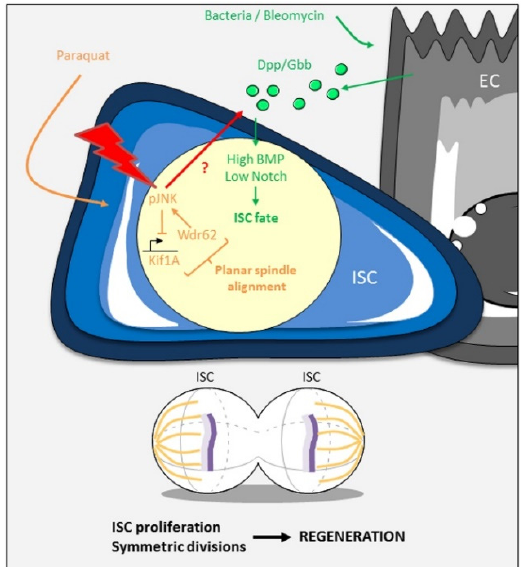
Figure 4. Stress-response of the gut by increased symmetric divisions. JNK-induced orientation of the mitotic spindle, Dpp/BMP-driven ISC fate and fast enteroblast differentiation through strong adhesion allow the gut to produce more ISC and differentiated cells to compensate for the loss of damaged cells. JNK signaling might be the central stress sensor (red flash). Activated JNK can then act directly on the planar spindle alignment and also could induce the expression of the Dpp/BMP ligands (red arrow). See the main text for details.